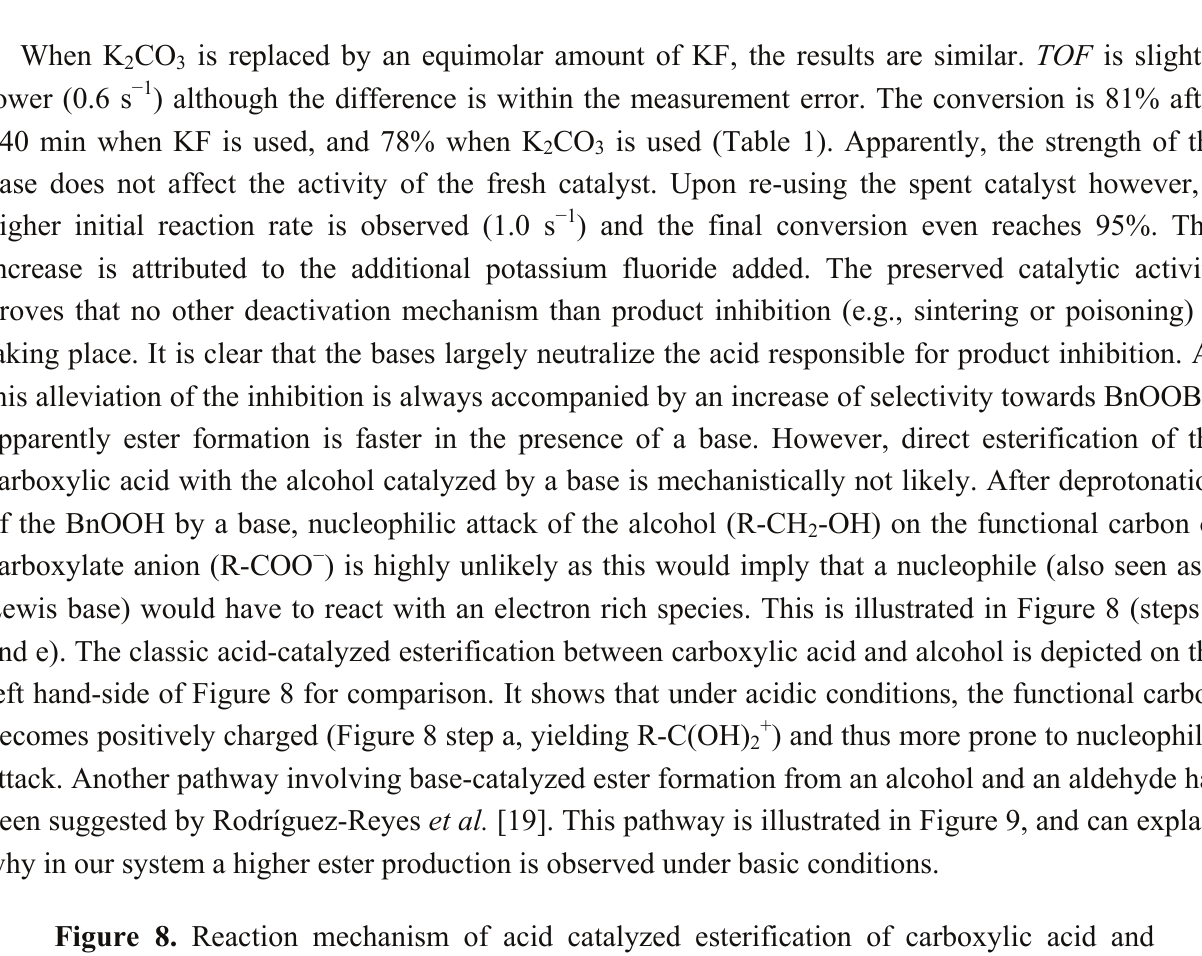
Figure 8. Reaction mechanism of acid catalyzed esterification of carboxylic acid